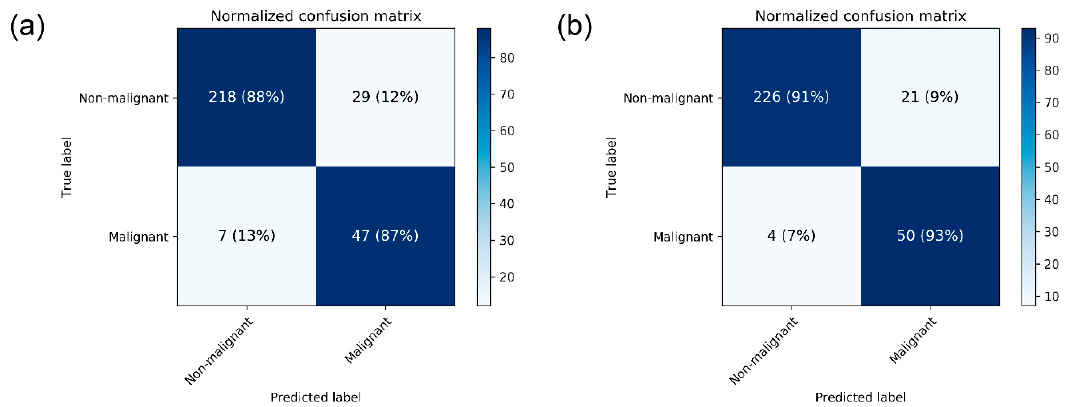
Figure 2. Heatmap of confusion matrix for breast cancer detection by the best performing ( a ) DenseNet-169 and ( b ) EfficientNet-B5.